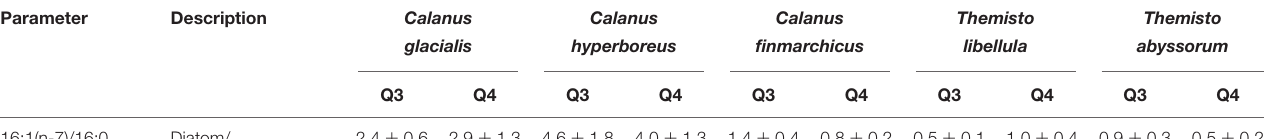
TABLE 3 | Trophic marker fatty acid ratios (mean ± SD) in copepods and amphipods during summer (Q3) and winter (Q4). Parameter Description